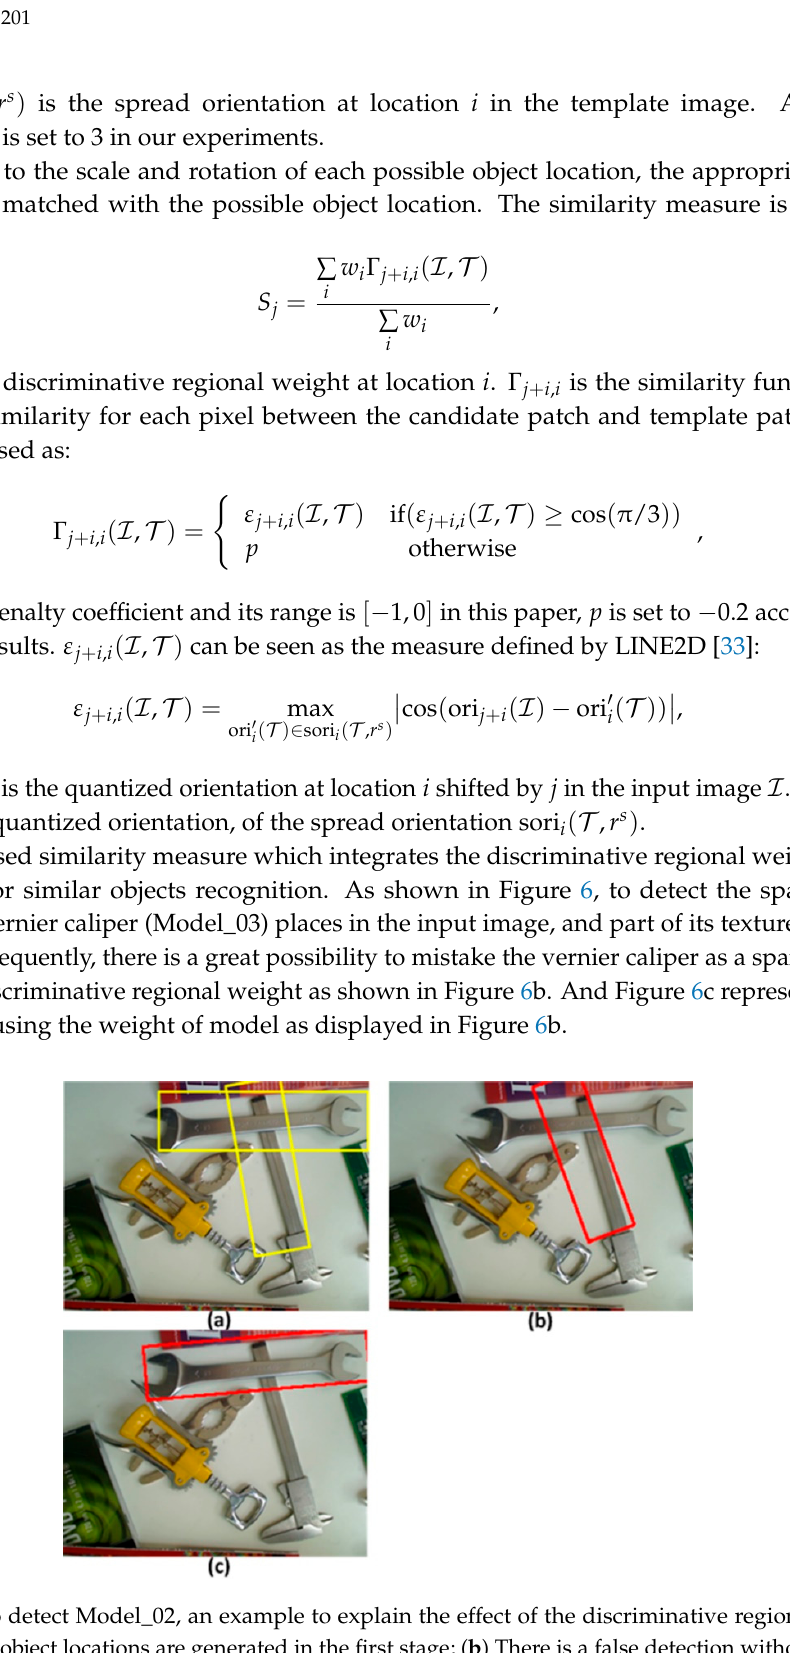
Figure 6. To detect Model_02, an example to explain the effect of the discriminative region weight. ( a ) Possible object locations are generated in the first stage; ( b ) There is a false detection without using a discriminative region weight; ( c ) Applying the discriminative region weight can eliminate other negative candidate regions in the second stage.